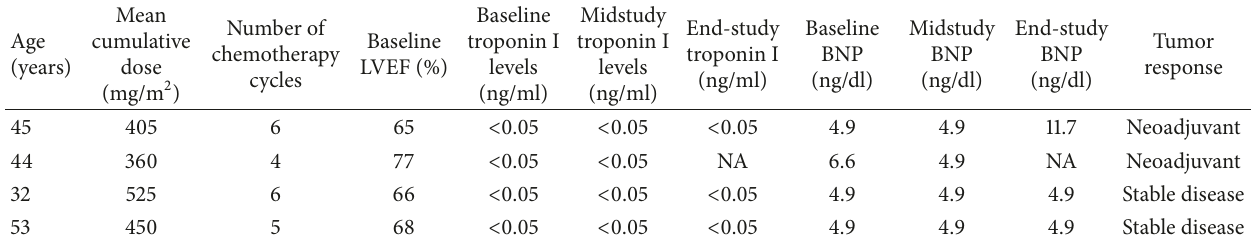
Table 2: Clinical characteristics of 4 patients who developed subclinical cardiotoxicity.